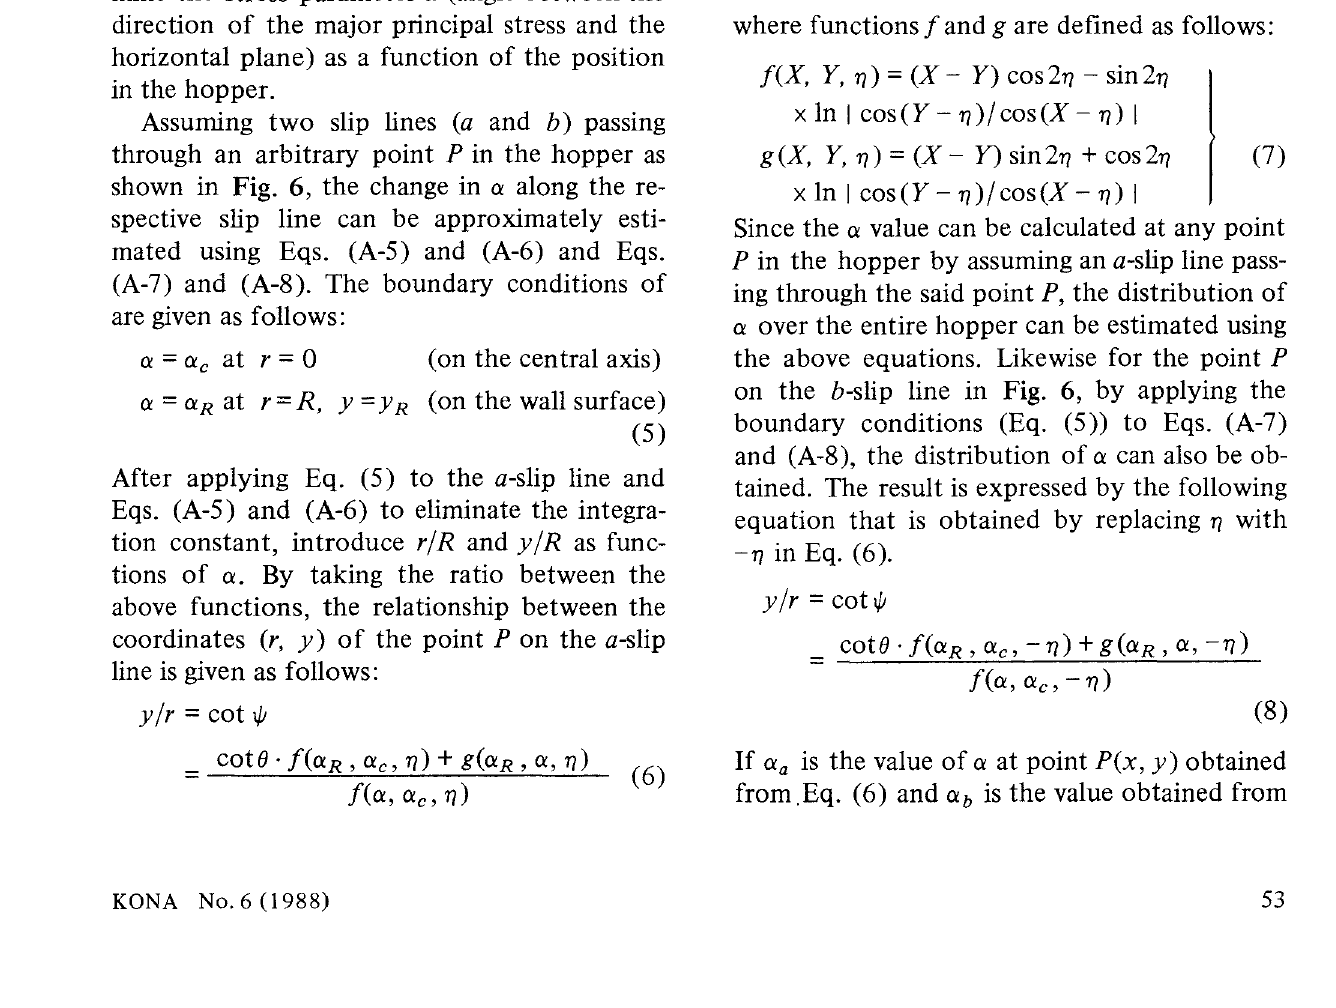
Fig. 6 Schematic diagram showing slip lines and boundary values of